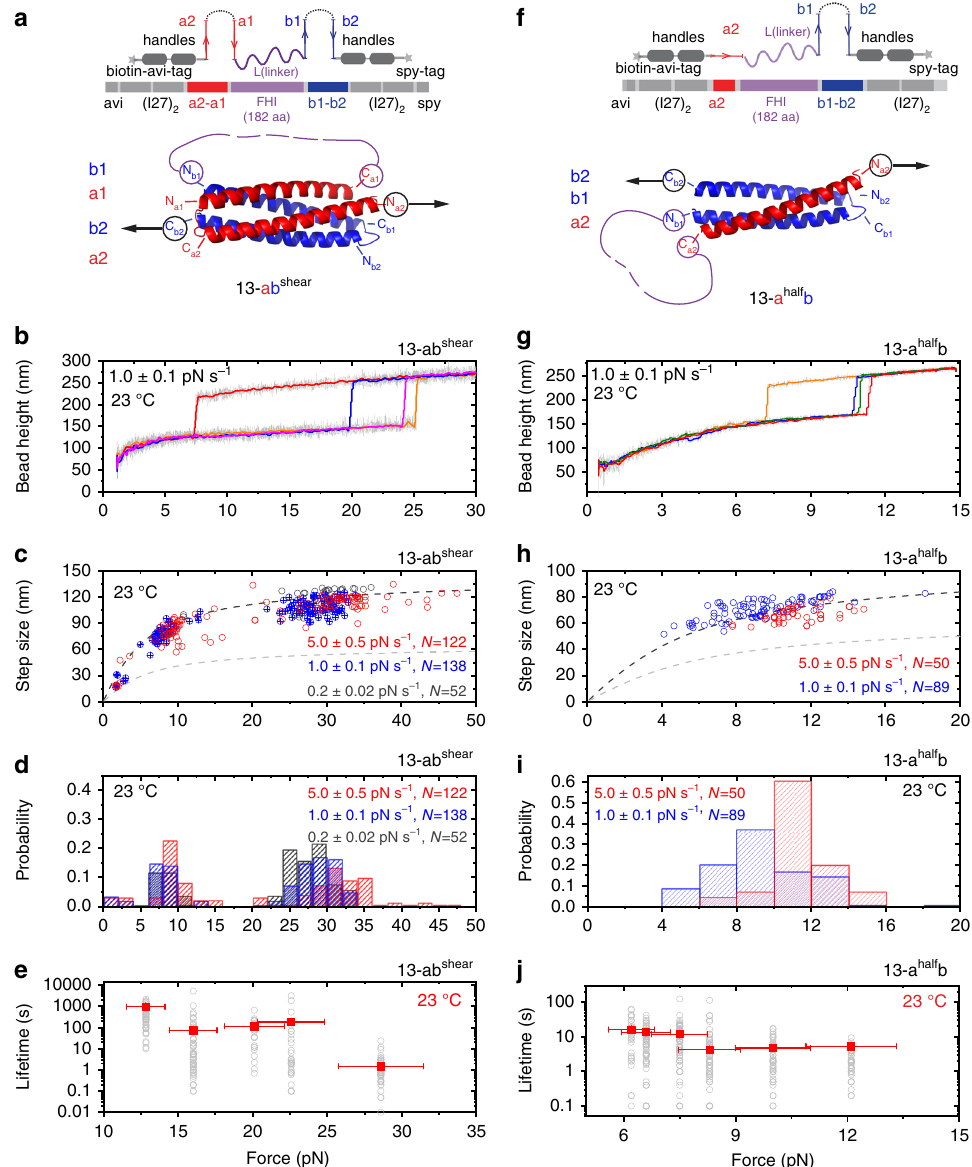
Fig. 2 Modulating the mechanical stability of helix-bundles. a Top panel: design of the 13-a2a1Lb1b2 construct. Bottom panel: The expected structure of the 13-ab shear . b Four representative force – height curves of the 13-a2a1Lb1b2 construct obtained at 1.0 ± 0.1 pN s − 1 . The stepwise bead height jump indicates the force-induced rupturing (unlooping) of the 13-ab shear . c The force – step size graph of the force-dependent rupture transitions of the 13-ab shear that causes unlooping of the construct. The dash curves are theoretically predicted. d Normalized histograms of the 13-ab shear rupture forces. e Force- dependent lifetimes of the 13-ab shear . f Top panel: design of the 13-a2Lb1b2 construct. Bottom panel: the expected structure of the 13-a half b. g Four representative force – height curves of the single-molecule 13-a2Lb1b2 construct at 1.0 ± 0.1 pN s − 1 . The stepwise bead height jump indicates the force- induced rupturing (unlooping) of the 13-a half b. The force – step size graph of the force-dependent rupturing (unlooping) transitions of the 13-a half b. The dash curves are theoretically predicted. i Normalized histograms of the 13-a half b helix-heterotrimer rupture forces. j Force-dependent lifetimes of the 13-a half b helix-heterotrimer. For panels b – e and g – j : the experiments were performed at 23 °C. For panels c , d , h , and i , the number of data points obtained from >5 independent tethers are indicated. Force panels e and j , the solid squares represent the average lifetimes ( τ ) obtained by best- fi tting of the lifetime histogram to a single-exponential decay function. The hollow gray circles represent individual lifetimes ( N ~ 100 for each force) measured in experiments. p . The horizontal error bars indicate 10% of relative force uncertainty The vertical error bars indicate the standard errors of the lifetime obtained by τ ffiffiffiffiffiffiffi N (cid:1) 1 resulted from the force-calibration method. For panels b and g 20-points FFT smooth (colored lines) of the raw data (gray lines) are shown. Source data are provided as a Source Data fi